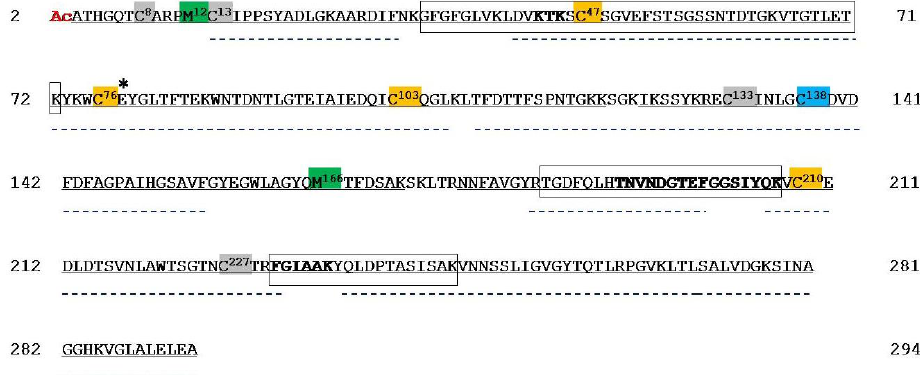
Figure 4. Sequence coverage map of hVDAC2 obtained by tryptic and chymotryptic digestion. Gray solid lines indicate the sequence obtained with tryptic peptides; dotted lines the sequence obtained with chymotryptic peptides. The carboxyamidomethylated cysteine residues are highlighted in grey, the partially oxidized cysteine residues are highlighted in orange, and the totally oxidized alanine residue is highlighted in light blue. The partially oxidized methionine residues are highlighted in green. The acetyl group linked to the N-terminal cysteine is shown in red. Unique tryptic peptides originated by missed-cleavages were used to distinguish and cover sequences shared by isoforms: they are indicated in the boxes. Sequences shared by isoforms are reported in bold. Numbering of the sequence considered the starting methionine residue, actually deleted during protein maturation. Aspartic acid residue 77 shared by hVDAC1 and 2 is marked by an